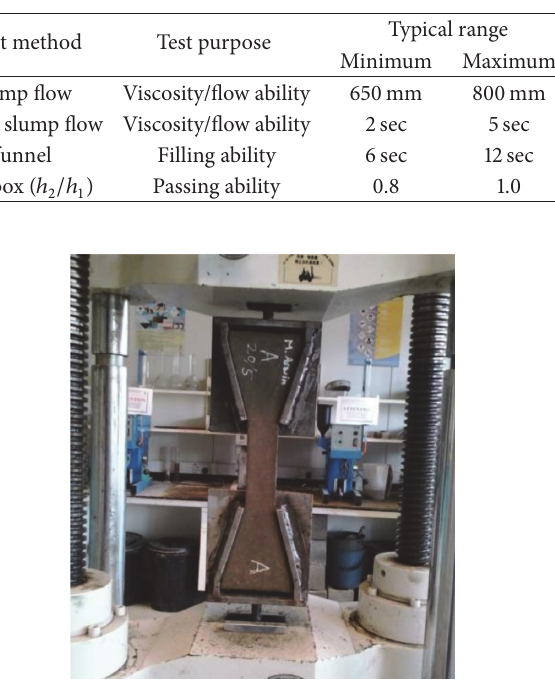
Table 3: Test methods for evaluating the fresh properties of self- compacted concrete.